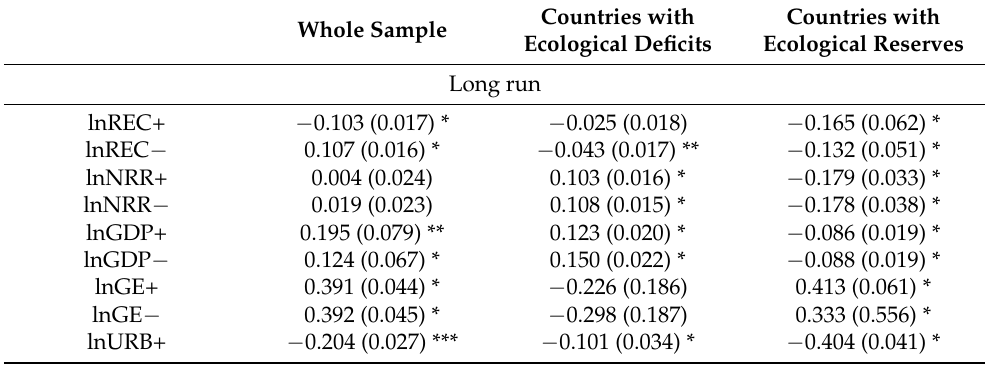
Table 8. Results of asymmetric ARDL model.